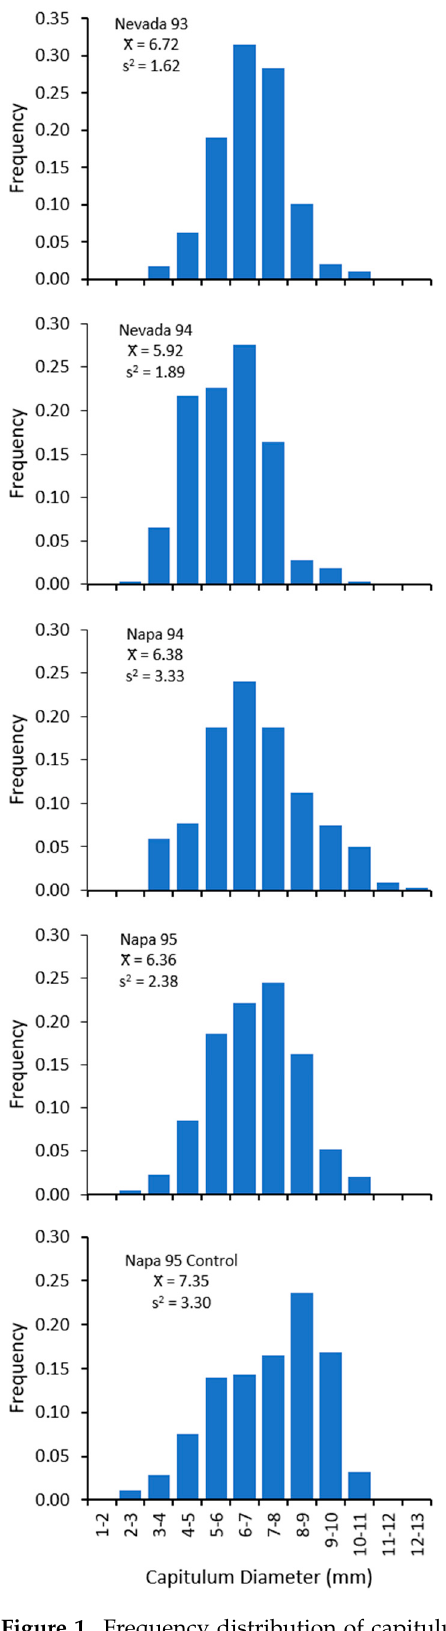
Figure 1. Frequency distribution of capitulum size for Centaurea solstitialis plants sampled from Fig 1 transects at two research sites during 1993 through